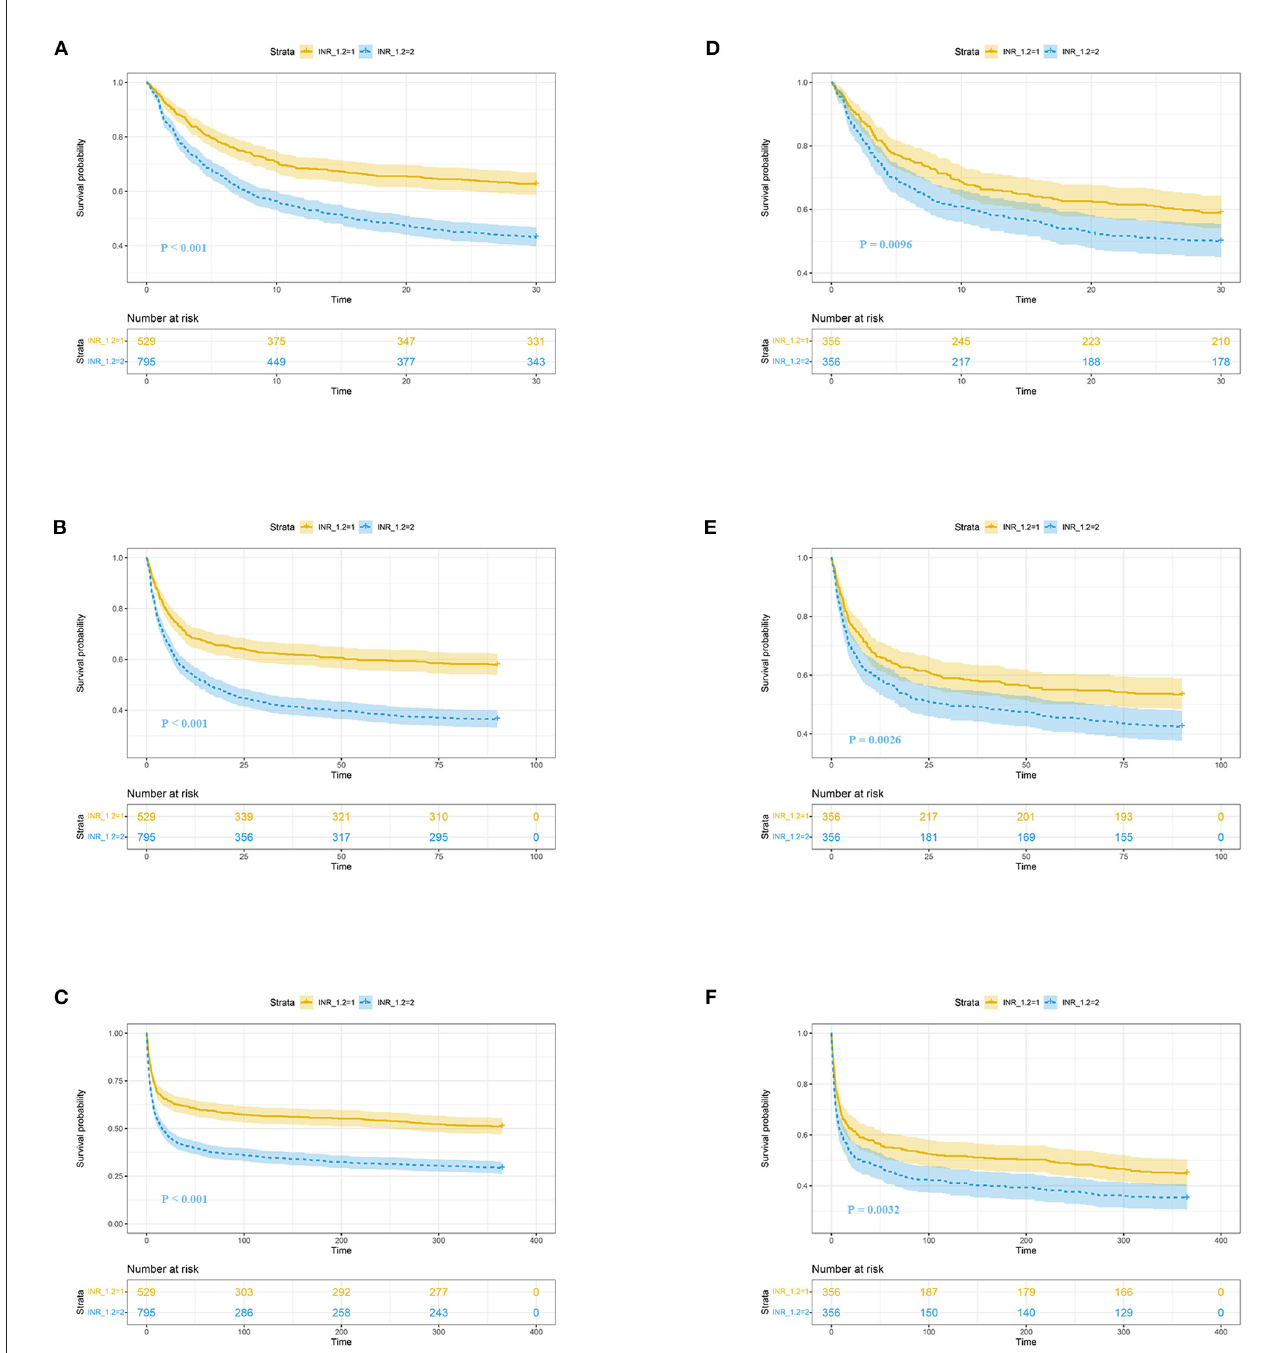
FIGURE3 K-M survival curves of post-CA patients with high (blue, INR ≥ 1.2) and low (yellow, INR < 1.2) INR at 30-day (A, D) , 90-day (B, E) , and 1-year (C, F) follow-up. (A–F) Reflect the results before and after propensity score matching, respectively. CA, cardiac arrest; INR, international normalized